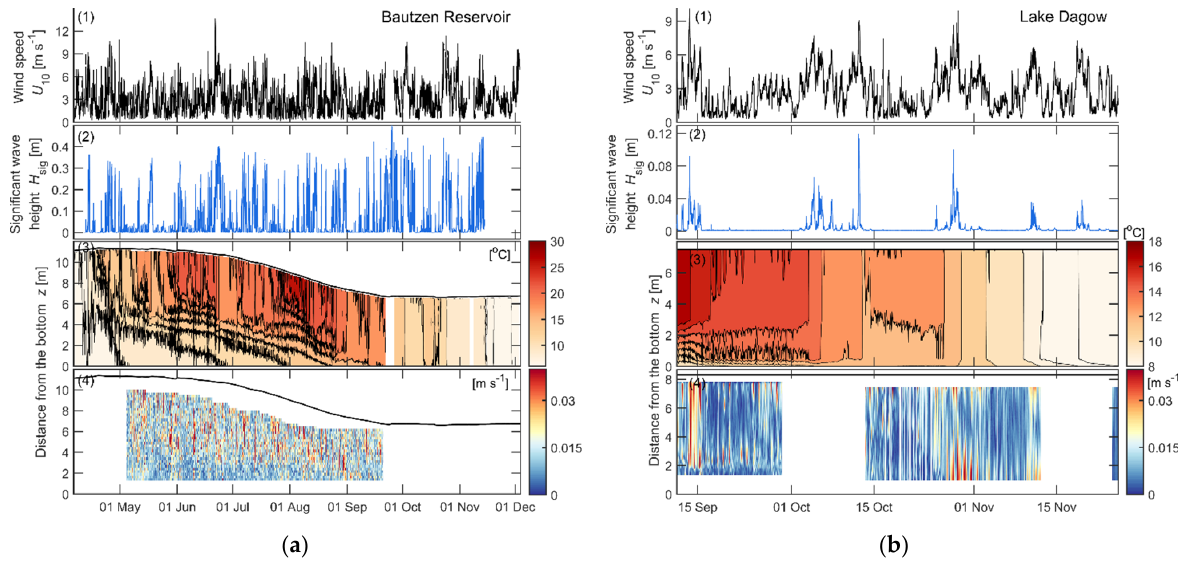
Figure 2. Overview of wind forcing and hydrodynamic conditions in ( a ) Bautzen Reservoir and ( b ) Lake Dagow. From the top to the bottom: (1) wind speed corrected to a height of 10 m; (2) significant wave height; (3) temperature profile (color denotes temperature, lines show isothermal depths); (4) flow velocity profiles (velocity magnitude). The black lines mark the location of the water surface. All data are shown at 30 min resolution.